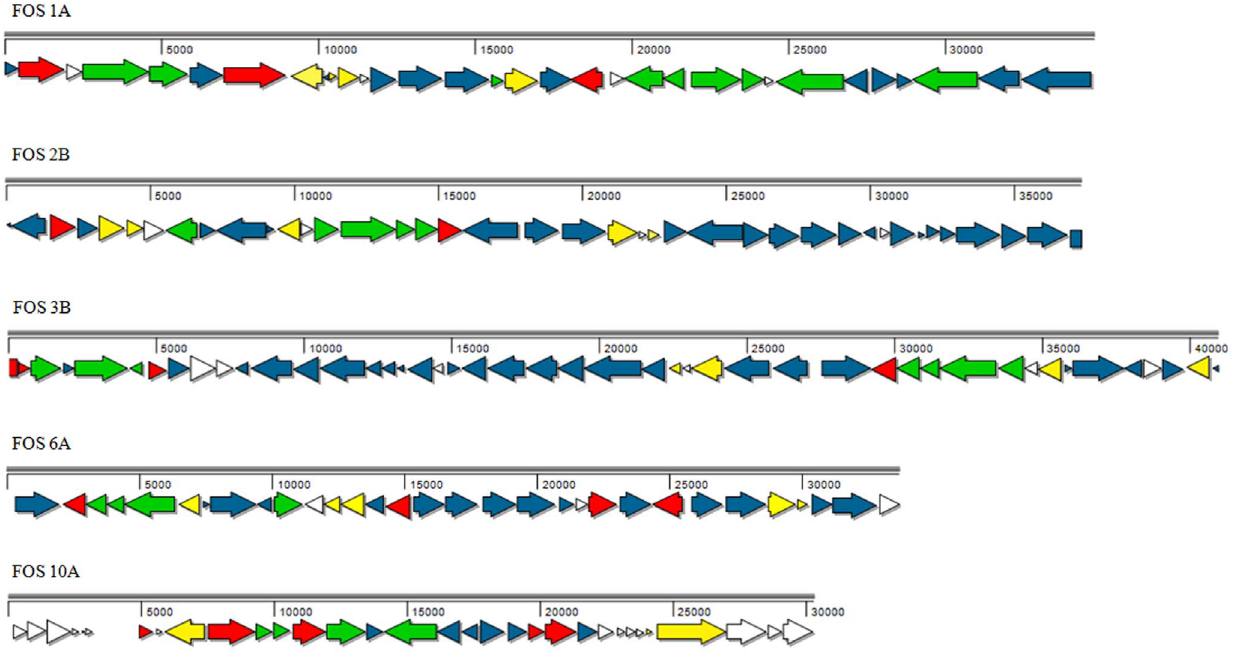
Figure 2. Schematic representation of the sequence annotations of the entire insert in five metagenomic fosmid clones. The identified open reading frames (ORFs) are shown in arrows, and the start and stop codons and the coding direction are indicated. The ORFs are color coded according to their functional category assigned by COG (Clusters of Orthologous Groups of proteins). Blue arrows: metabolism; green arrows: cellular processes and signaling; red arrows: information storage and processing; yellow arrows: poorly characterized; white arrows: not in COG. Further details on the ascribed putative function for each ORF are indicated in Supplementary tables S2 to S6.